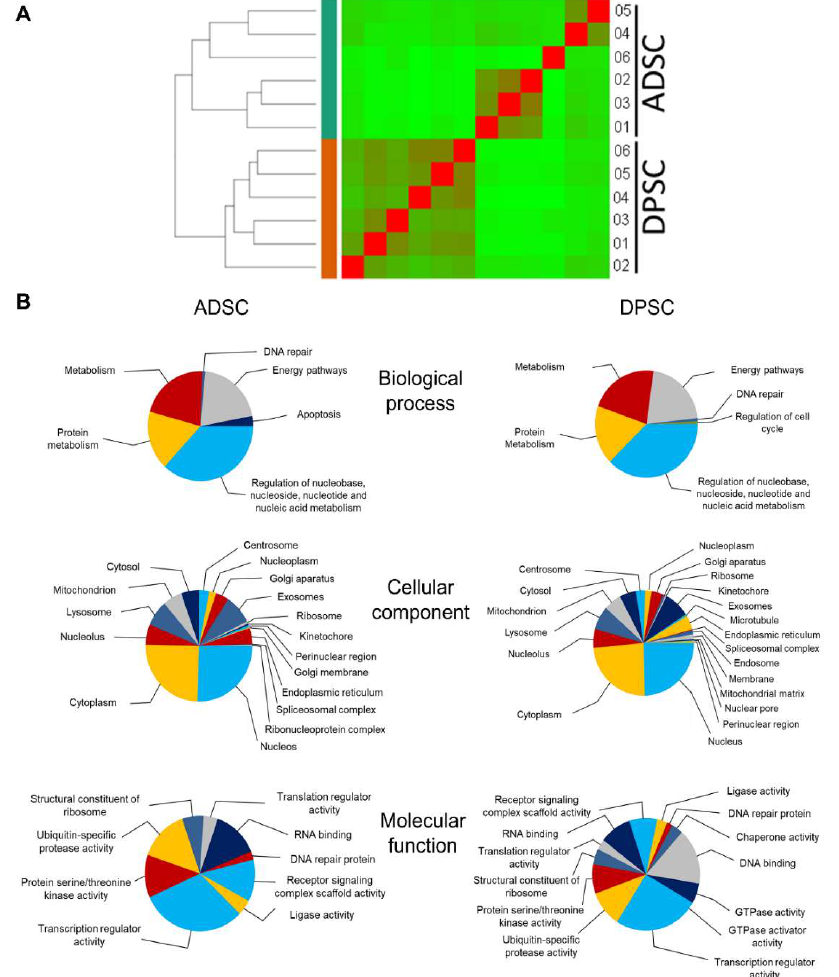
Figure 4. Hierarchical clustering and functional enrichment analyses of mRNAs present in ADSCs and DPSCs. ( A ) Hierarchical clustering based on RNA sequencing. ( B ) Gene Ontology (GO) enrichment analysis of all genes identified in ADSCs and DPSCs showing the most enriched terms for biological process, cellular component and molecular function. The pie chart shows selected significantly enriched categories ( p -value < 0.05 for biological process and p -value < 0.01 for cellular components and molecular function). GO analysis was conducted with Funrich software. mRNA: messenger RNA; ADSCs: adipose tissue-derived stromal cells; DPSCs: dental pulp-derived stromal cells; RNA: ribonucleic acid; GO: Gene